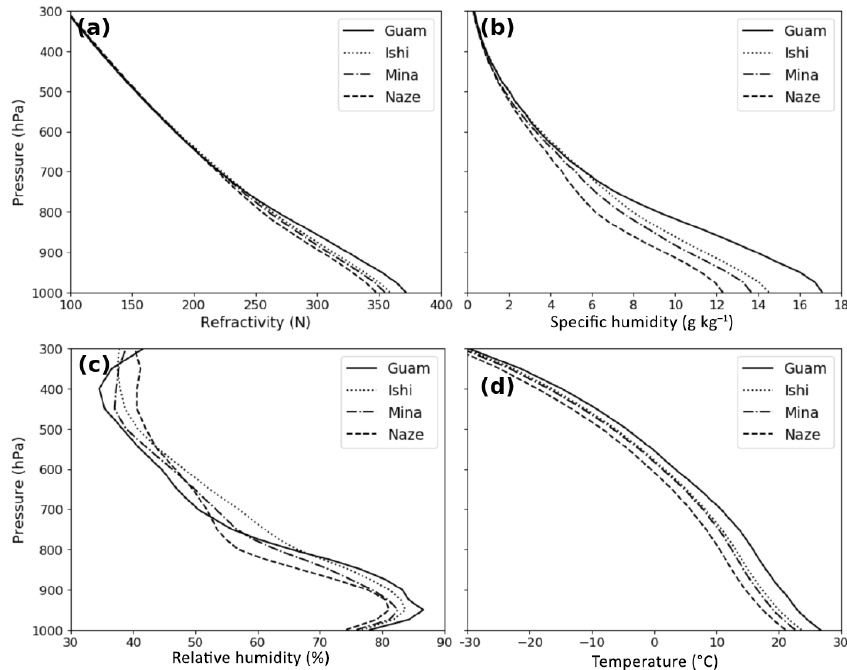
Figure 1. ERA annual average profiles on the 25hPa grid for (a) refractivity, (b) specific humidity, (c) relative humidity, and (d) temperature at all four